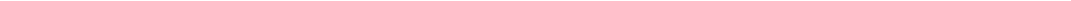
Figure 3 | Interplay of PI3K-AKT-mTORC and integrin b 1/integrin linked kinase pathways in IR MCL cells. ( a , b ) Western blots ( a ) and flow cytometry ( b ) showing increased and sustained integrin b ( b 1) expression in IR MCL cells compared to parental (Sen) cells in the absence and presence of ibrutinib treatment (6h). ( c ) Cell adhesion assay showing increased and sustained cell adhesion of IR MCL cells to stromal HK cells in the absence and presence of ibrutinib treatment (12h). ( d ) Colony formation assay showing enhanced clonogenic growth in IR MCL cells in the absence and presence of ibrutinib treatment. ( e , f ) Cell adhesion assay ( e ) and western blots ( f ) showing stable integrin b 1 (CD29) knockdown with shRNAs significantly decreased rictor, pAKT, p4EBP and pS6K1 in IR MCL cells and significantly attenuated cell adhesion of parental (Sen) and IR MCL cells to HK stromal cells. ( g ) Co-immunoprecipitation revealed b 1 and ILK form a complex in Jeko-1-IR and HBL-2-IR cells and b 1 knockdown abolished b 1/ILK complex formation. *indicates the specific band for integrin b 1 ( h ) Co-immunoprecipitation showing ILK co-immunoprecipitates with rictor to form a more abundant complex in Jeko-1-IR and HBL-2-IR cells versus that shown in their parental (Sen) cells. ( i ) Co-immunoprecipitation showing suppression of b 1/ILK co-immunoprecipite formation in parental (Sen) but not in IR MCL cells after ibrutinib treatment in HBL-2-IR and Jeko-1-IR cells. Scale bar, 10 m m. Results in a – g are representative of at least three independent experiments or means ± s.d. from at least three biological replicates. For a – f , relative changes of proteins were measured by quantitative densitometry and indicated below each lane. See also Supplementary Figs 3, 8 for full gel scan of the